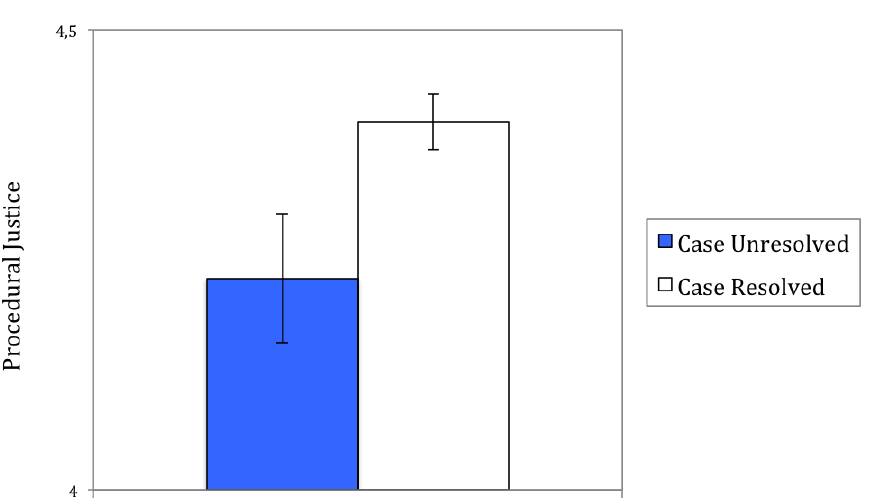
Figure 3 . Number of resolved cases compared with unresolved cases in relation to increasing levels of perceived procedural justice. Procedural justice judgments are on 5-points scales with higher values indicating higher levels of perceived procedural justice. Error bars represent standard errors of the mean.